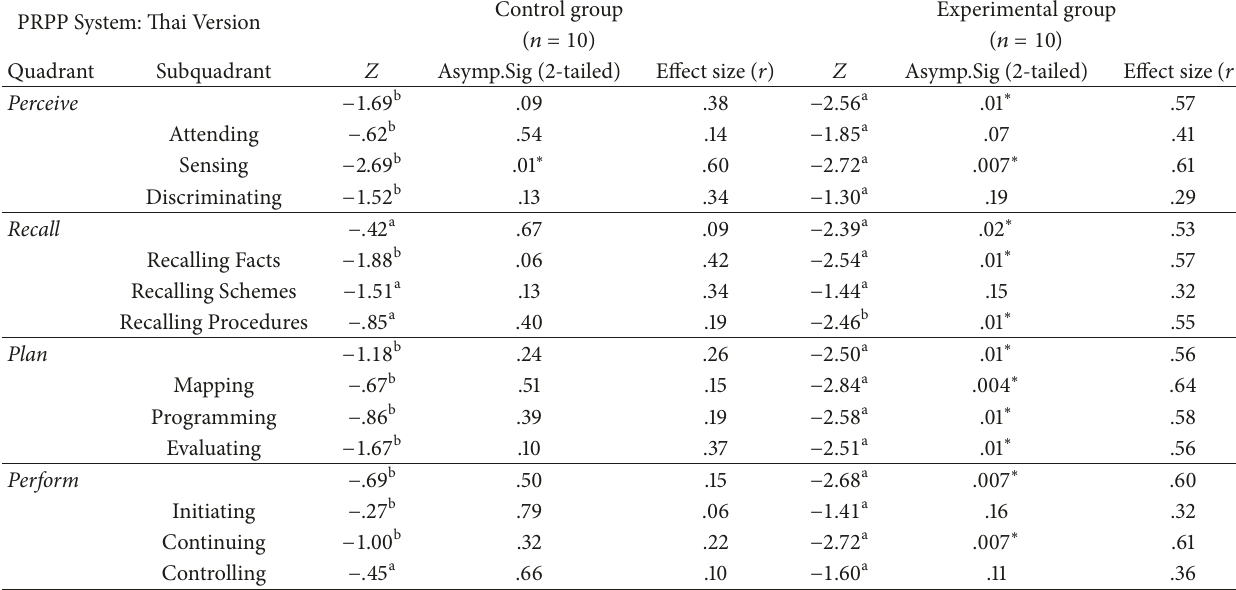
Table 6: The comparison of the quadrant and subquadrant pretest and posttest scores on the academic activity in the control group and experimental